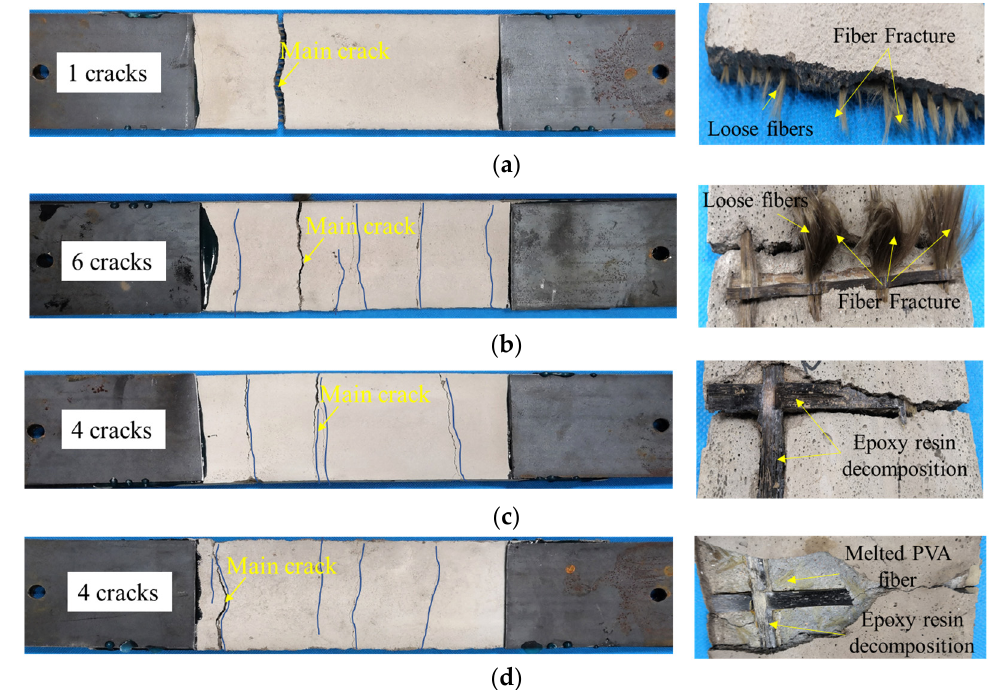
Figure 10. Failure and cracking modes of the BGRM after exposure to elevated temperature: ( a ) BT5- 300-2h; ( b ) BT25-300-2h; ( c ) BG50-300-2h; ( d ) BG50F-300-2h. 300-2h; ( b ) BT25-300-2h; ( c ) BG50-300-2h; ( d )